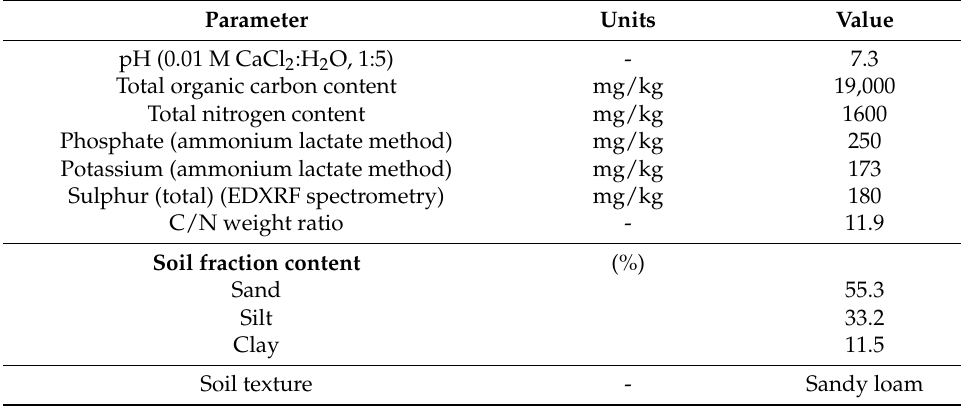
Table 7. Chemical and physical properties of the soil of the Dolnje Brezovo experimental area used in the present study. Parameter Units